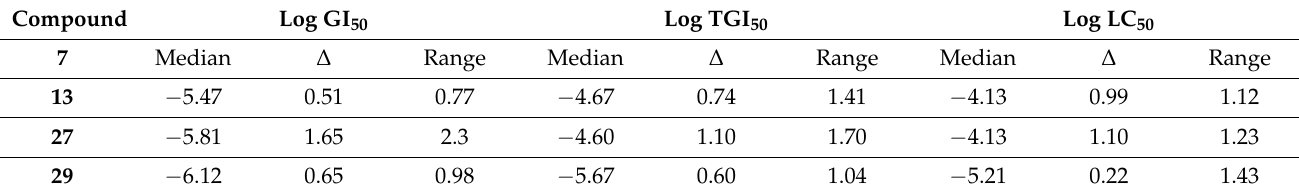
Table 2. Cytostatic (log GI 50 ) a and cytotoxic (log LC 50 ) b and log TGI 50 c data for compounds 7 , 13 , 27 and 29 .